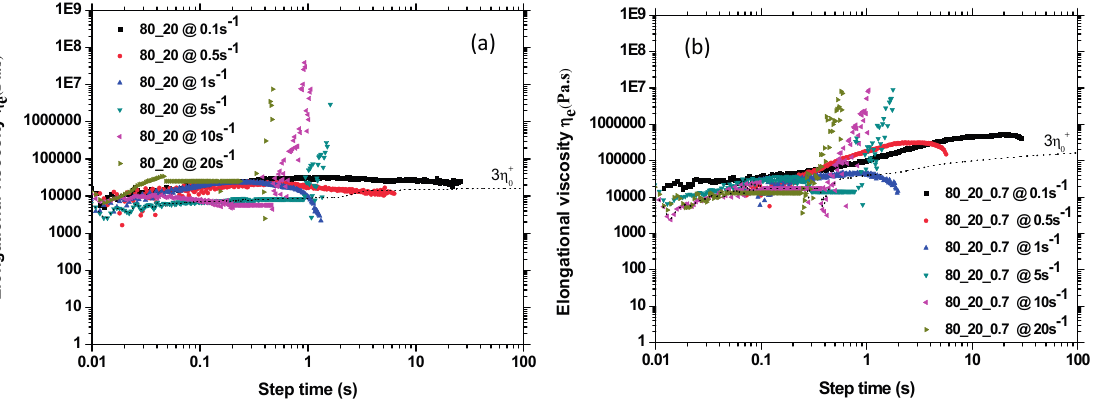
Figure 11. Elongation viscosity versus step time ( t ) 180 °C for the ( a ) uncompatibilized and ( b ) compatibilized PLA–PBAT blends at different elongation